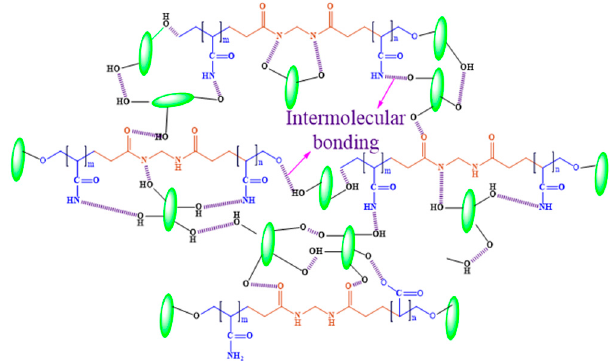
Figure 3. PAC hydrogel formation mechanism.